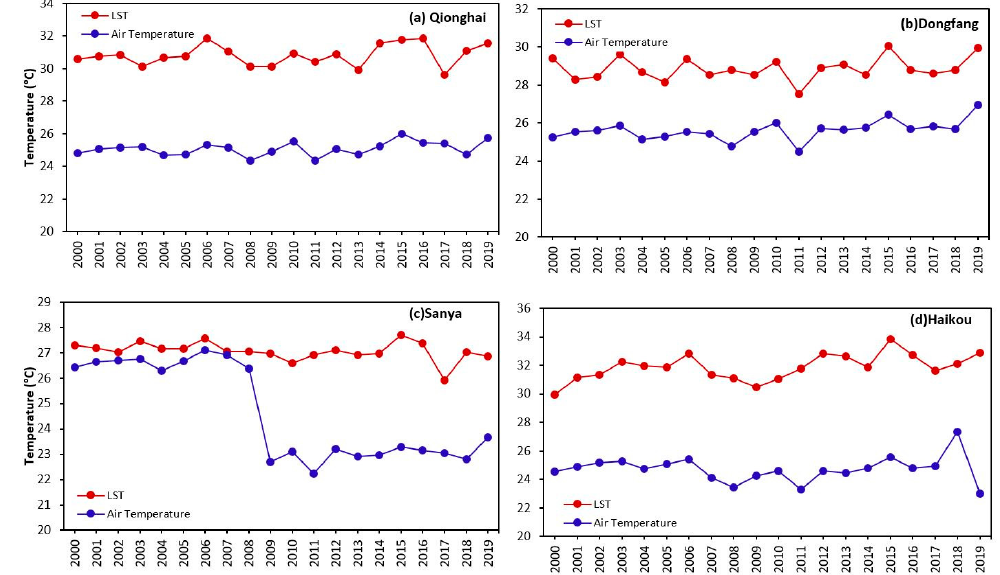
Figure 3. Comparison of annual variation of MODIS derived Land Surface Temperatures (LST) and air temperature from four weather stations on Hainan Island.